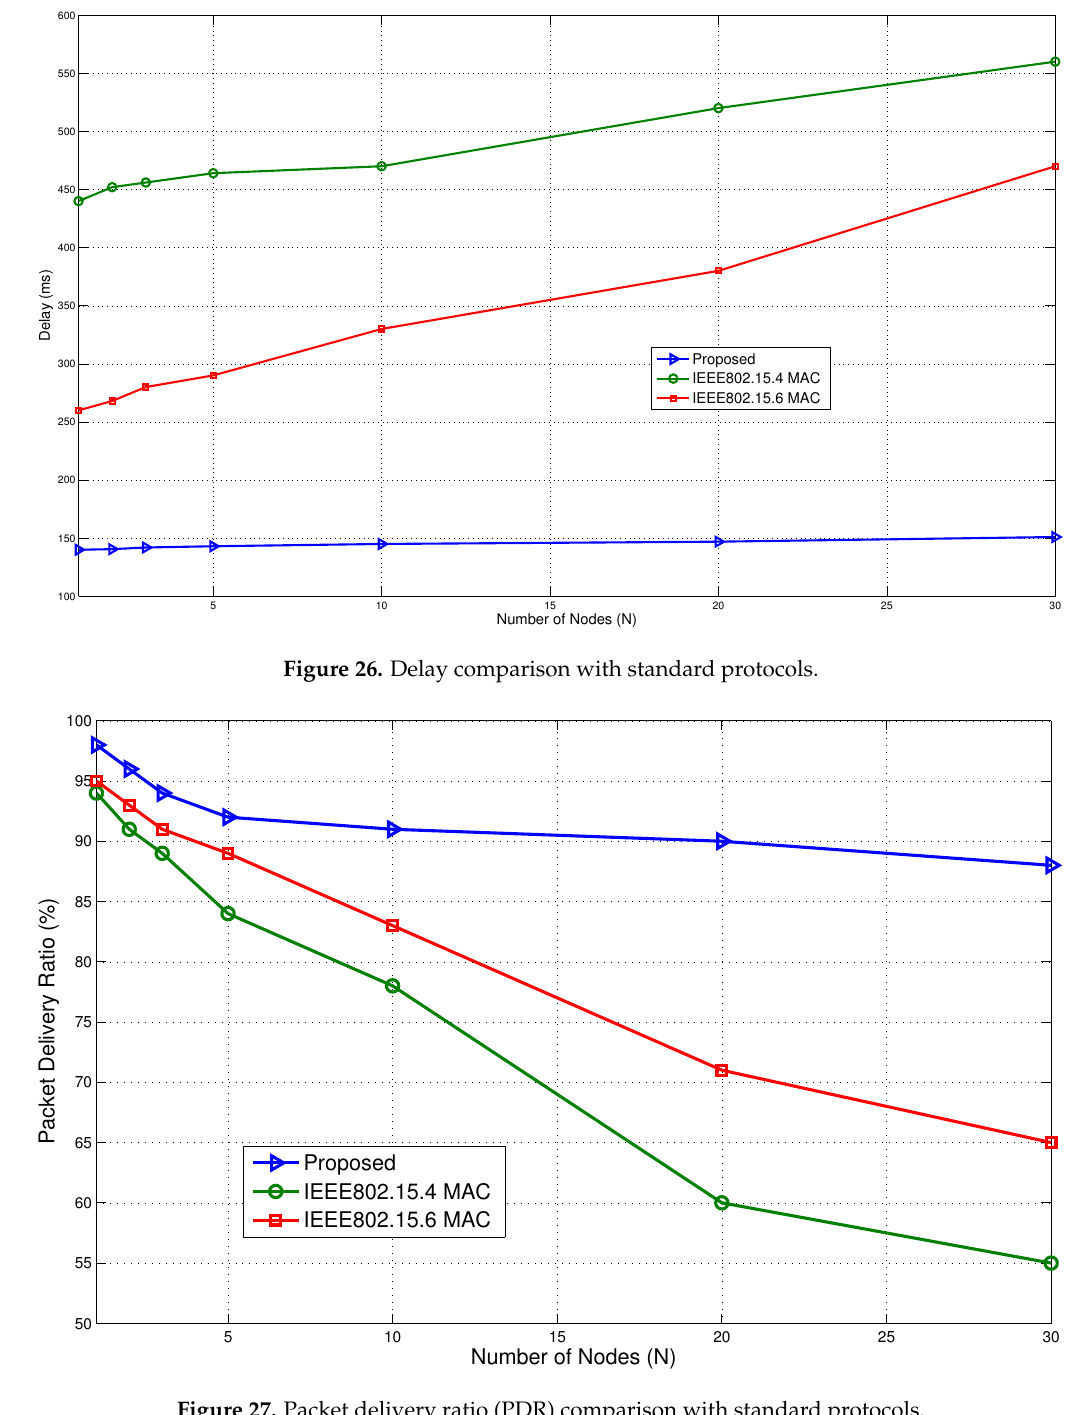
Figure 27. Packet delivery ratio (PDR) comparison with standard